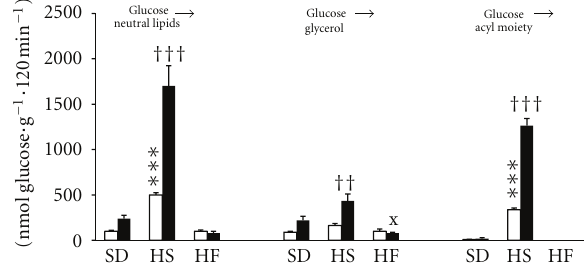
Figure 2: Glucose incorporation into lipids in liver slices in vitro . The utilisation of glucose for esterification and de novo fatty acid synthesis was determined in the same sample as glucose incorporation into total lipids (described in Section 2). open bars = fasted animals; closed bars = fed animals. All data are means SEM, n = 6 individual incubations for each bar. ∗∗∗ P < 0.001 HS-fasted versus SD-fasted; †† P < 0.01, ††† P < 0.001 HS-fed versus SD-fed; x P < 0 . 05 HF-fed versus SD-fed. the radioactive label is found in cytosolic TAG 90 min